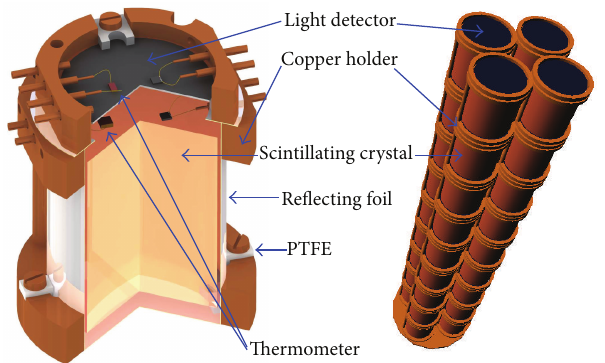
Figure 1: LUCIFER layout. Left: single module detector consisting of the scintillating bolometer and the light detector. Right: 9-floor tower constituted by 36 single